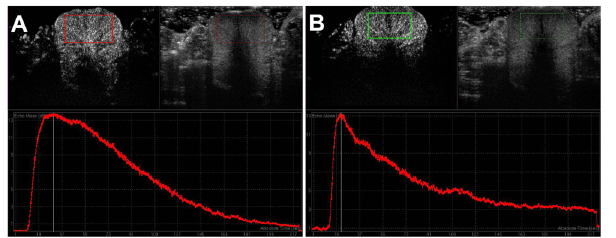
Fig 1. Analysis of contrast-enhanced ultrasound in the microbubble-enhanced ultrasound group. The upper panels in A (before treatment) and B (after treatment) showed the contrast-enhanced ultrasound image with two modes: contrast mode (left) and tissue mode (right). A rectangular region of interest was defined inside the frontal prostate, excluding the acoustically attenuated area. The lower panels showed a time intensity curve (TIC) generated automatically by QLAB software. (A) After a rapid ascension in acoustic intensity, the TIC showed a relative plateau around peak intensity (representing microbubble diffusion to the mesenchyme) and then a slow descent. (B) The ascension and descension of the TIC after treatment were steeper, and the diffusion plateau became imperceptible or even disappeared.